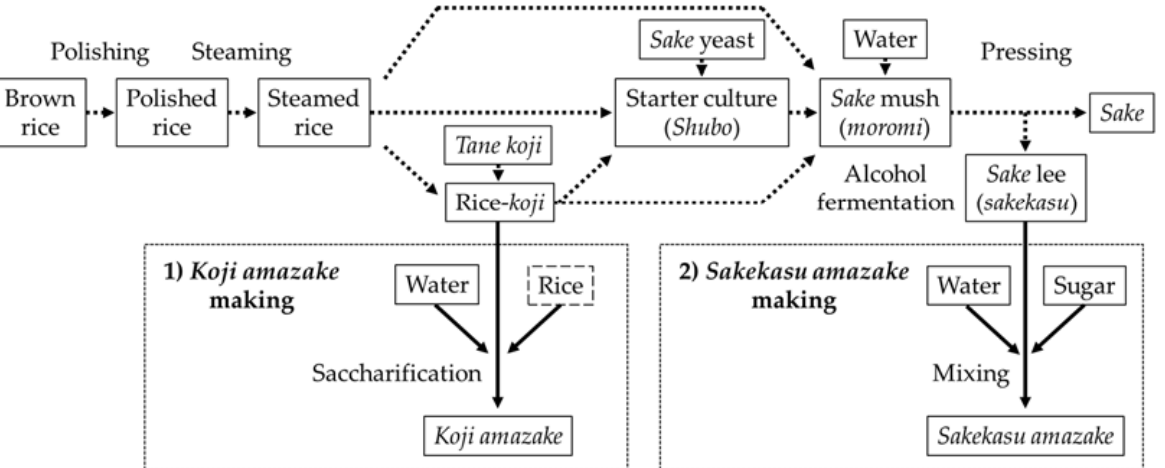
Figure 1. Relationship between sake brewing and the amazake production process.